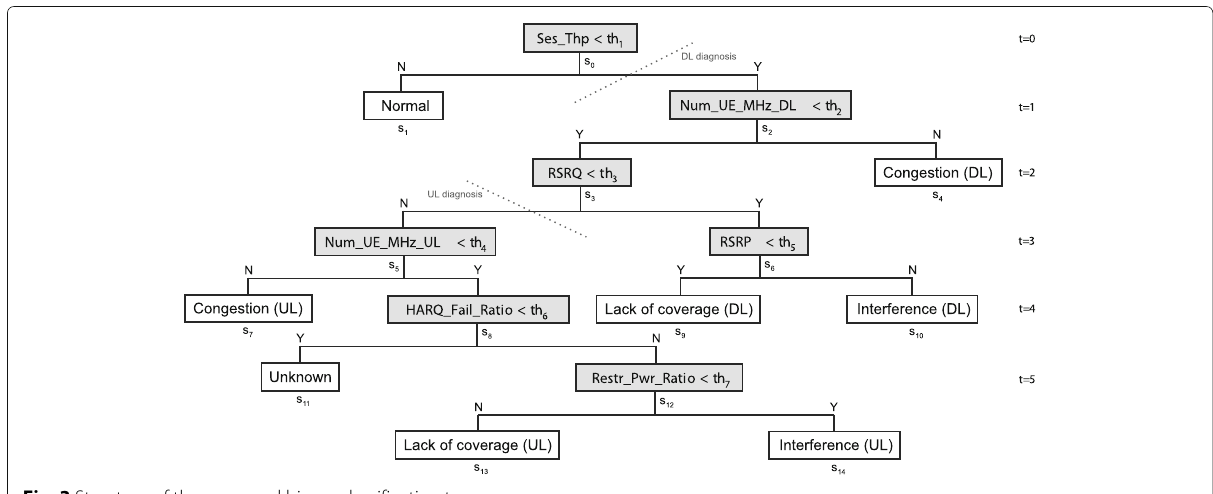
Fig. 3 Structure of the proposed binary classification tree